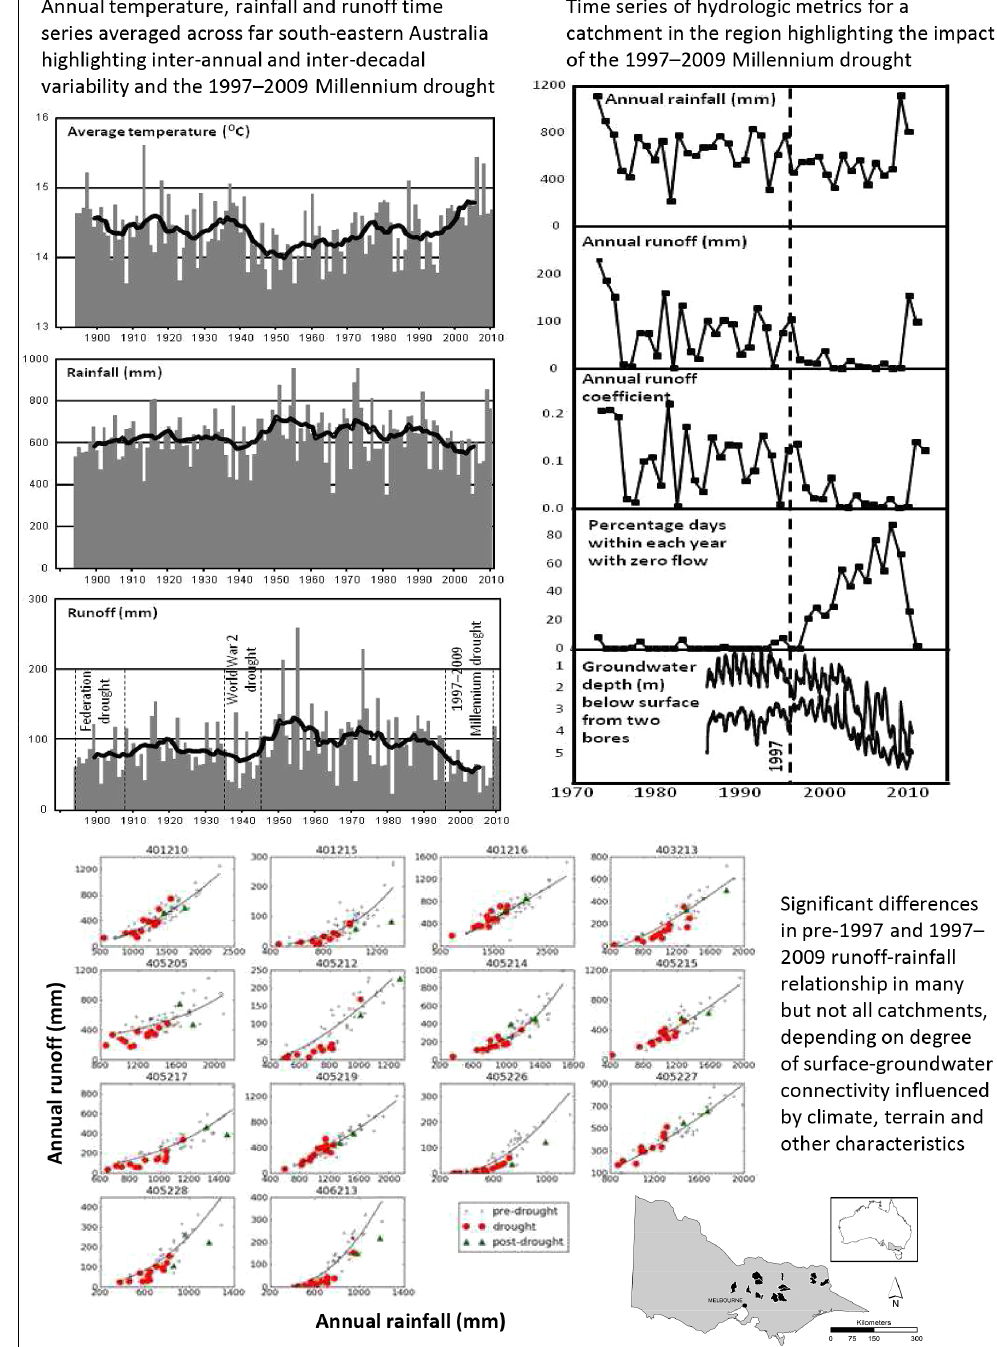
Figure 1. The Millennium Drought in far south-eastern Australia and its influence on hydrology and climate-runoff